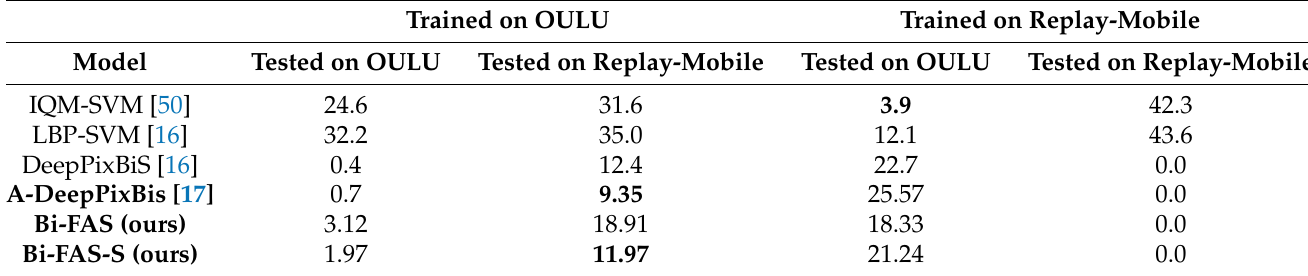
Table 5. Inter-dataset comparison of our proposed models on Protocol I of the OULU-NPU dataset and the Replay-Mobile grandtest protocol represented using half-total error rate ( HTER ) values in percentages